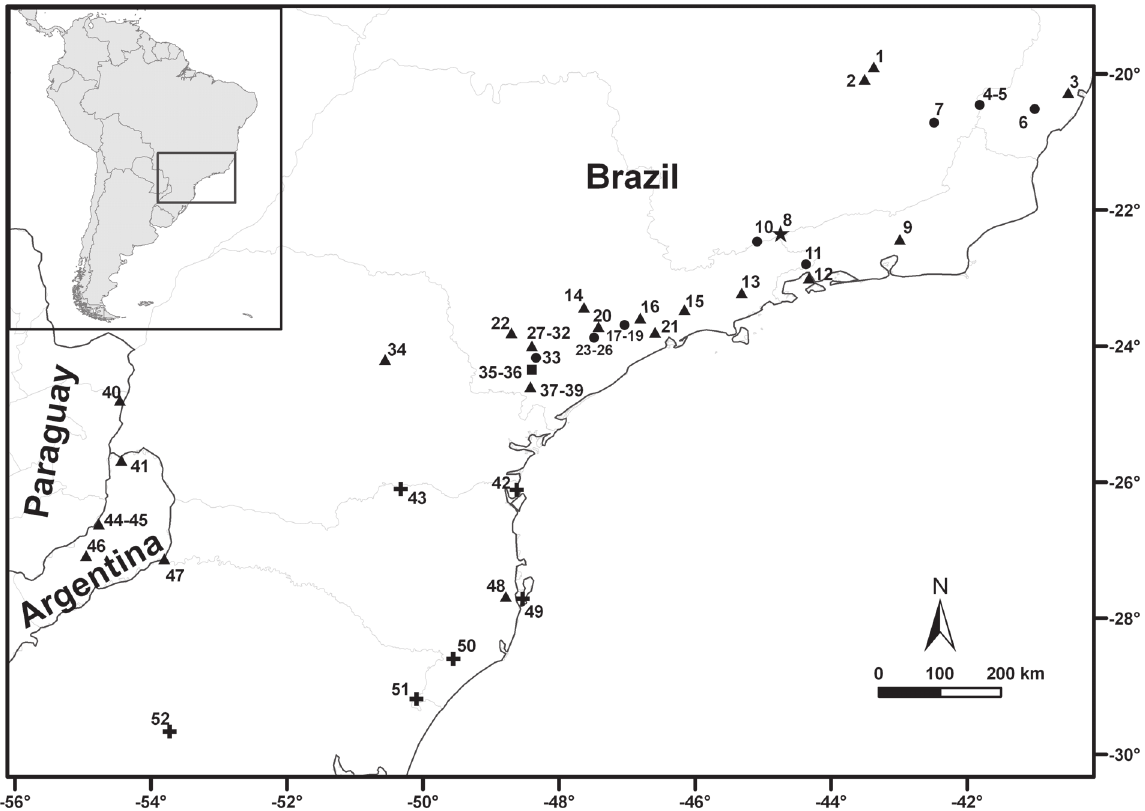
Figure 13. Collecting localities of J. ossitenuis (circles), J. pictipes (triangles) and J. rimofrons (star). Syntopy of J. ossitenuis and J. pictipes is represented by a square. Localities of specimens originally identified as Juliomys sp. (C HEREM et al. 2004, C HEREM 2005, P ARESQUE et al. 2009, L IMA et al. 2010) are represented by a cross. Numbers correspond to the localities listed in Appendix